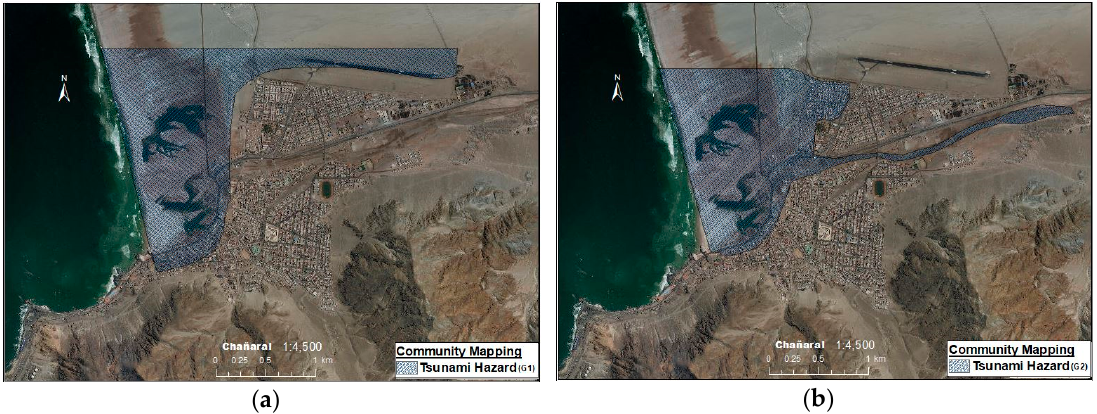
Figure 10. Tsunami risk perception in Chañaral: ( a ) Group 1, ( b ) Group 2.